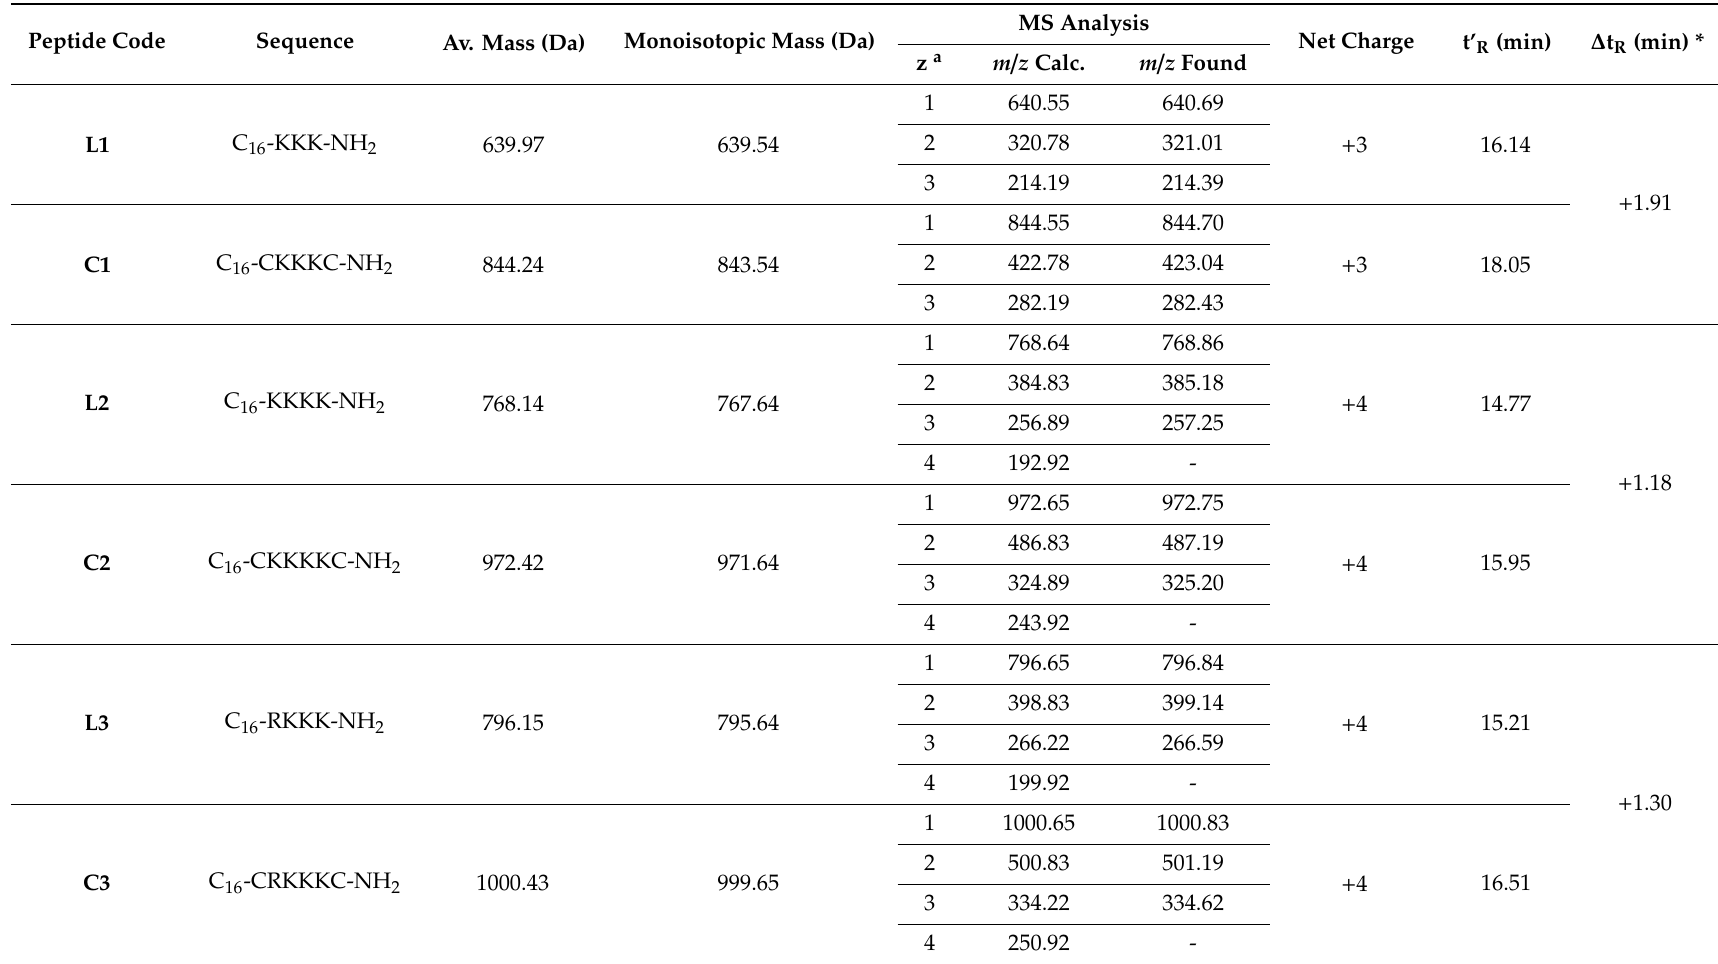
Table 1. MS analysis, reduced retention time of lipopeptides (t’R), and calculated di ff erences in retention time between the parent molecule and its analog ( ∆